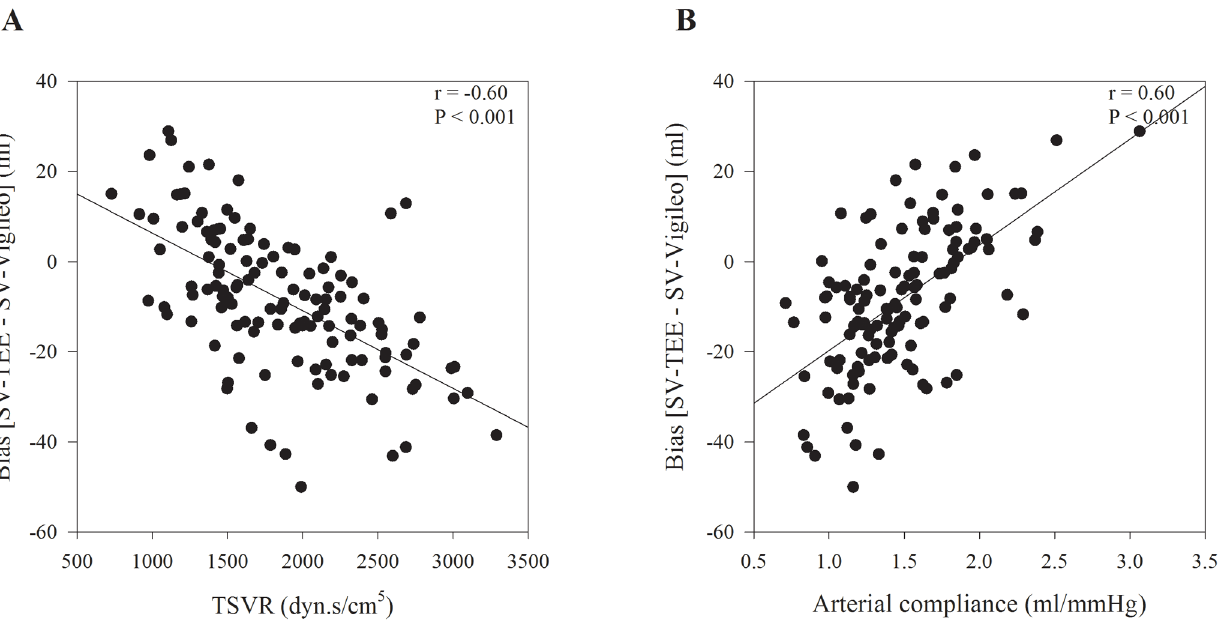
Fig 3. Correlation analyses (A) between total systemic vascular resistance (TSVR) and the differences between the stroke volumes measured using transesophageal echocardiography (SV-TEE) and the third-generation FloTrac/Vigileo ™ system (SV-Vigileo) and (B) between arterial compliance the differences between the SV-TEE and the